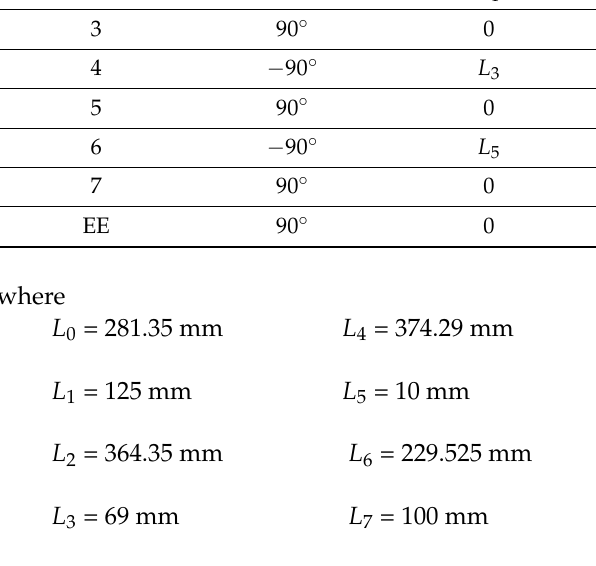
Table 1. Denavit–Hartenberg parameters.